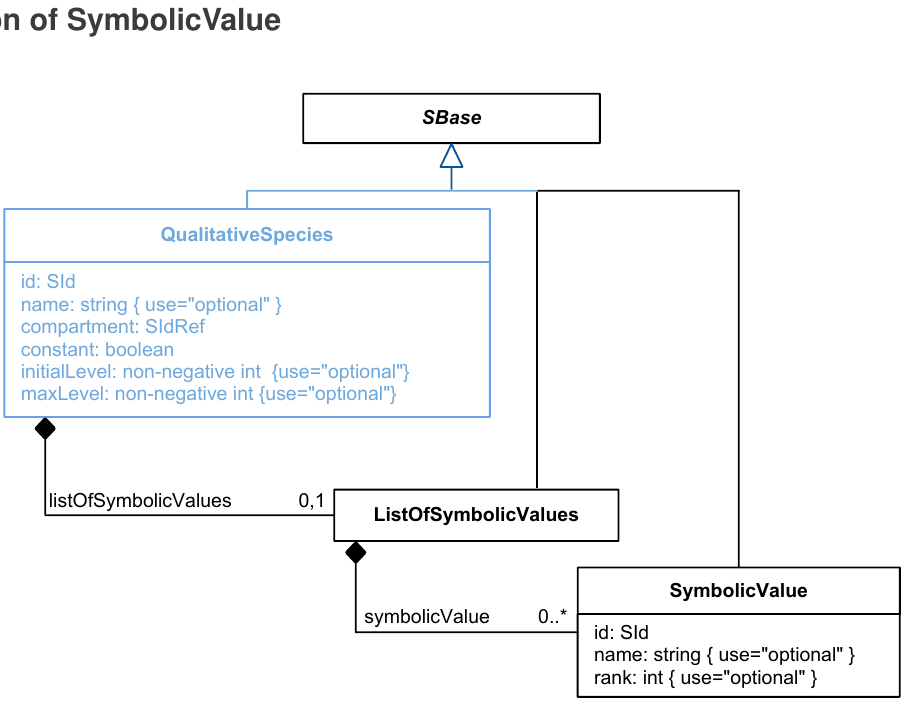
Figure 7: Possible future extensions of the QualitativeSpecies